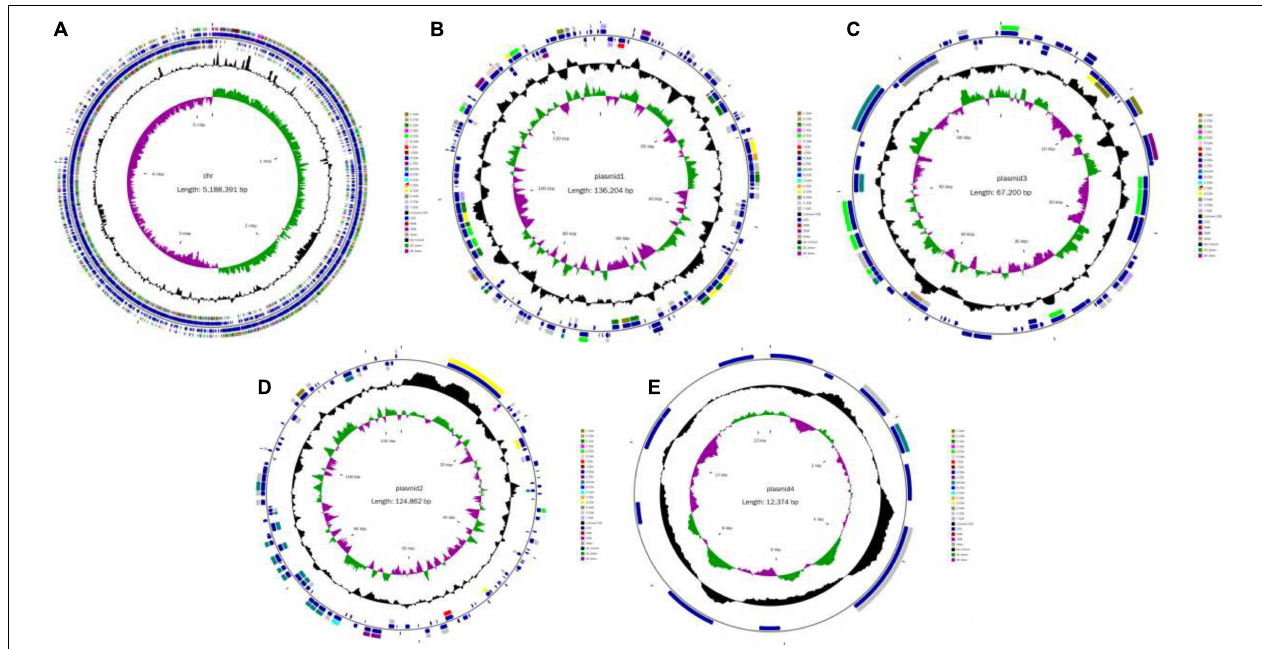
FIGURE 1 | Circular genome map of Bacillus aryabhattai SK1-7. (A) Genetic map of the circular chromosome. (B) Cycle map of Plasmid1. (C) Cycle map of Plasmid 2. (D) Cycle map of Plasmid 3. (E) Cycle map of Plasmid 4. The circles for chromosome from the outside to the center represent CDS, COG, KEGG, GO, tRNA, rRNA, GC content, and GC skew, respectively.